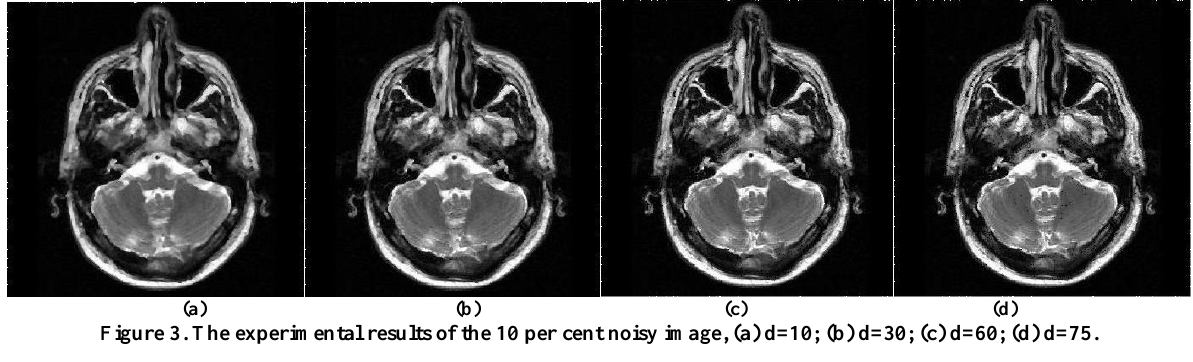
Figure 3. The experimental results of the 10 per cent noisy image, (a) d=10; (b) d=30; (c) d=60; (d) d=75.